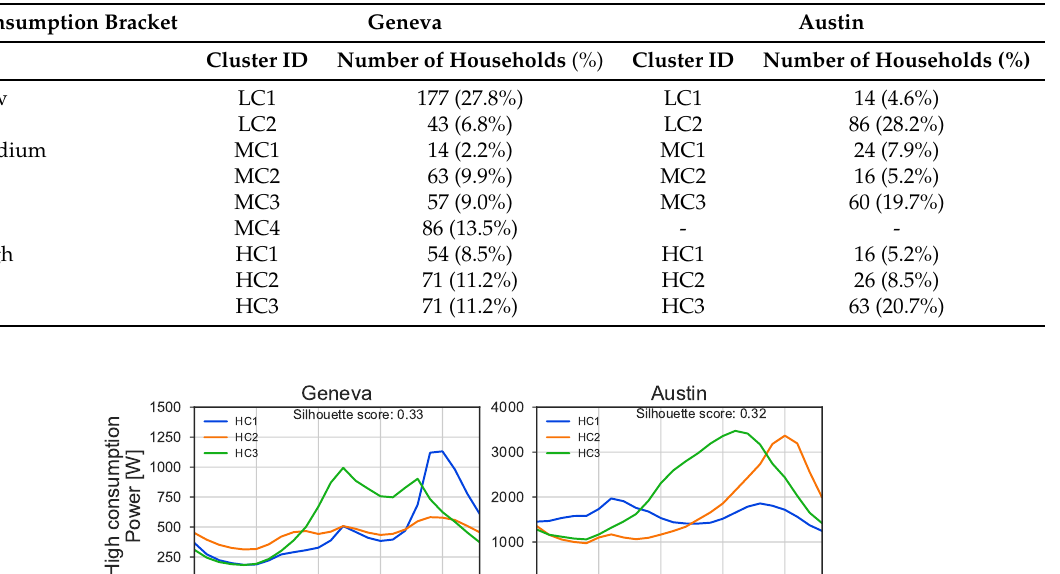
Table 4. Cluster nomenclature by consumption bracket and location. The assignation of every household depends on the statistical mode of the cluster outcome to determine the most common cluster ID throughout the year.